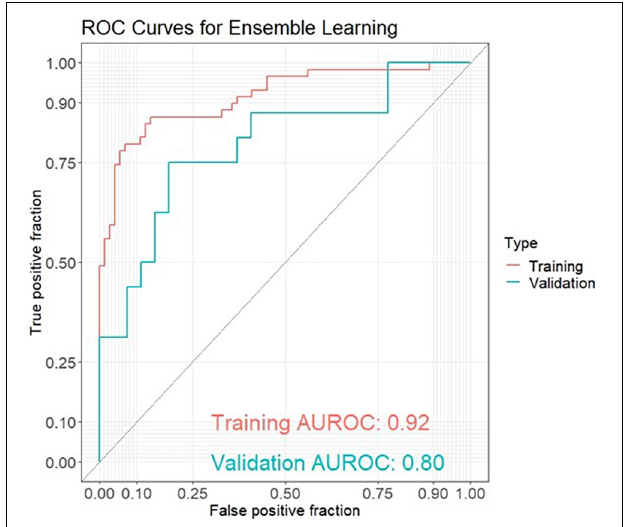
FIGURE 2 | ROC curves for ensemble learning for discrimination between amyloid-positive Alzheimer’s disease (AD) patients and healthy controls in a training set (AD: n = 59, HC: n = 73) and an independent validation set (AD: n = 16, HC: n = 27) including 4 models with 18 genera features, 17 GO (Gene Ontology) features, 26 KO [Kyoto Encyclopedia of Genes and Genomes (KEGG) ortholog] features and 4 clinical features (age, gender, BMI,